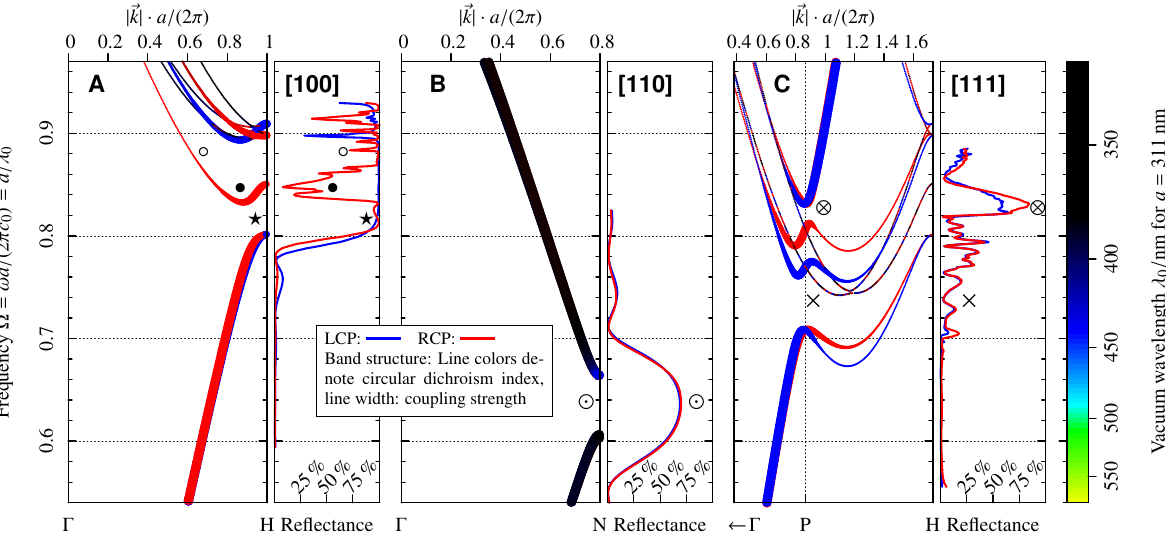
Figure 13. CBS diagram of the single gyroid photonic crystal along the [111] direction. The bands with a very large slope near ka {p 2 π q “ 2 are genuine bands. They represent perturbations of the six vacuum structure bands with G a {p 2 π q “ 1 { 3 ˆp´ 1 , ´ 1 , 2 q T and the two permuted vectors thereof. All six bands have an (cid:107) elliptical shape in the decay rate diagram, with the unperturbed vacuum semi-ellipse defined a 2 { 3 ´ k 2 by κ “ . 0